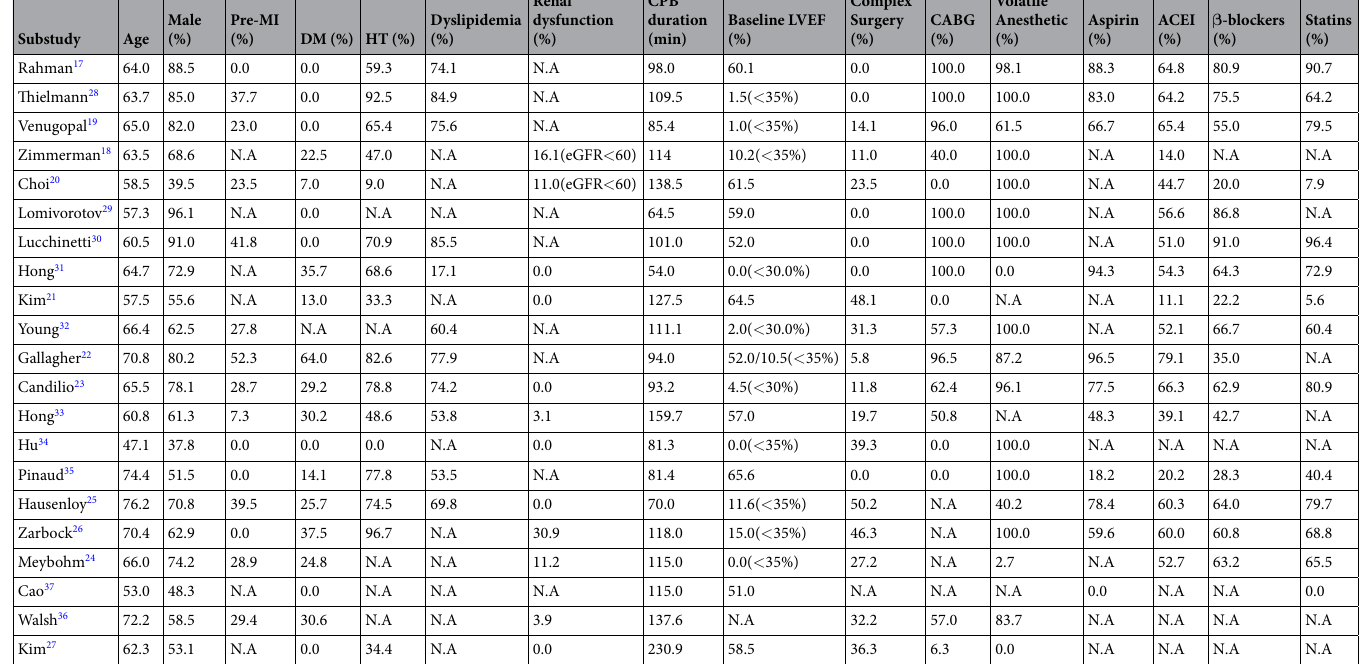
Table 2. Patient characteristics in all included randomized trials. Note: Pre-MI, previous myocardial infarction; DM, diabetes mellitus; HT, hypertension; CPB, cardiopulmonary bypass; eGFR, estimated glomerular filtration rate; LVEF, left ventricular ejection fraction; CABG, coronary artery bypass graft; ACEI, angiotensin-converting enzyme inhibitor; N.A, not available.